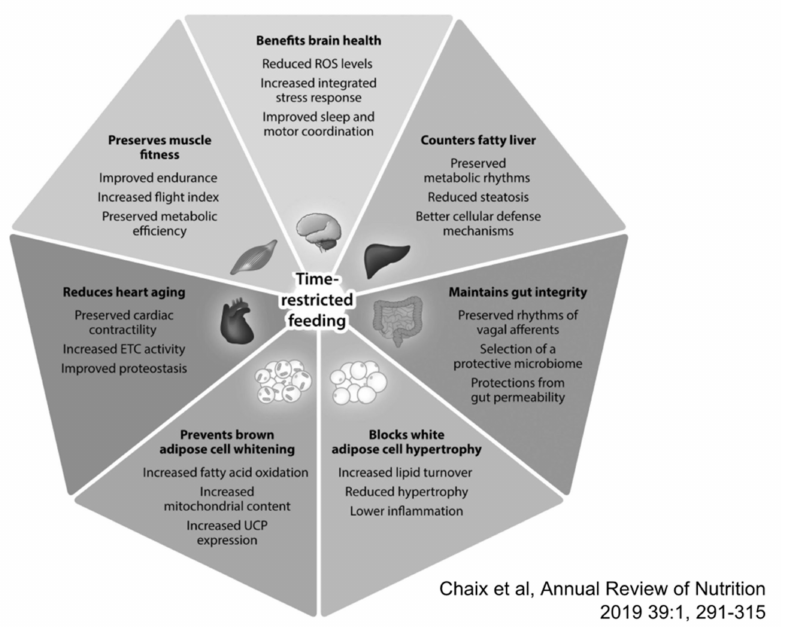
Figure 2. Reported benefits associated with time-restricted eating (TRE). Based largely on preclinical studies a wide range of benefits have been postulated for TRE, while clinical studies are non- conclusive to date. With permission from Chaix et al.